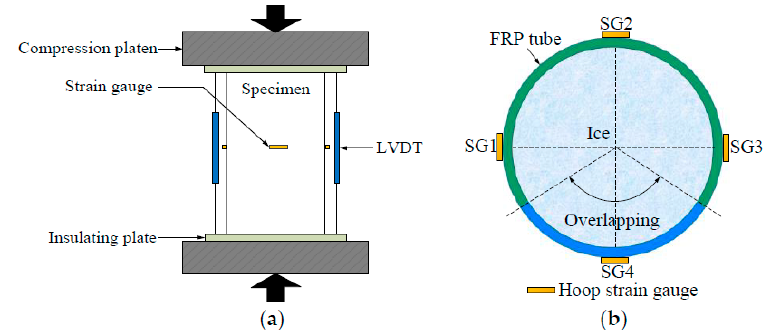
Figure 3. Test setup and instrumentation: ( a ) Test setup and linear variable displacement transducers (LVDTs); and ( b ) layout of strain gauges.